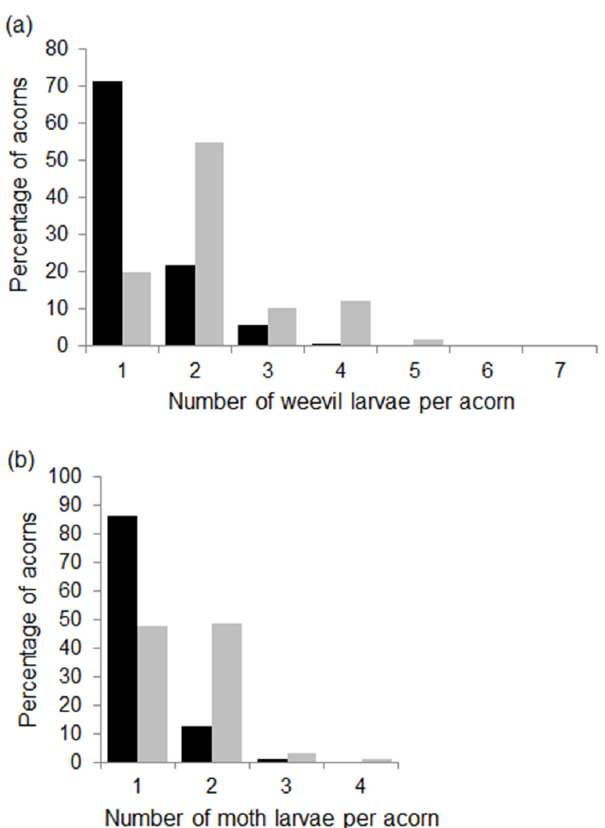
Figure 3. Percentage of acorns with different numbers of weevil ( a ) and moth ( b ) larvae per acorn in the 2014 (black bars) and 2015 (grey bars) fruiting seasons. Percentages were calculated from 619 and 504 acorns infested by weevils and from 345 and 227 acorns infested by moths in 2014 and 2015, respectively.